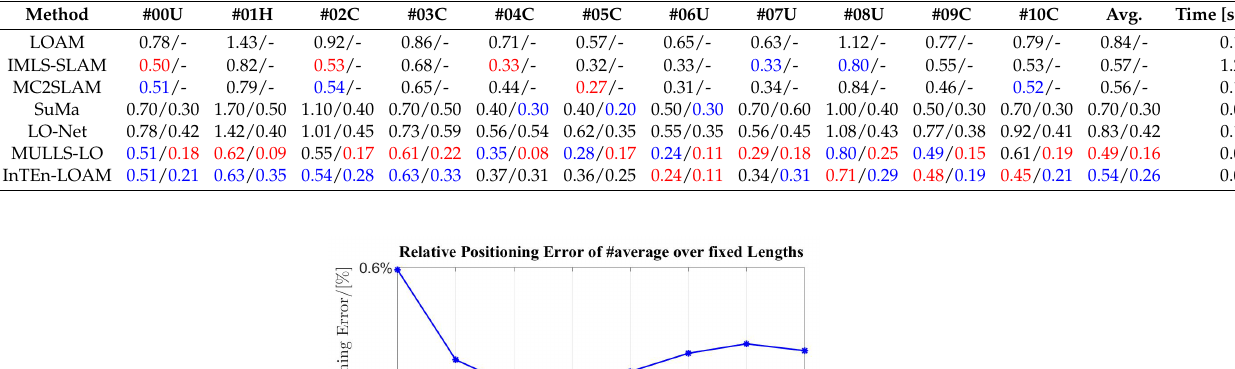
Table 1. Quantitative evaluation and comparison on KITTI dataset. Note: All errors are represented as average RTE [ % ] /RRE [ /100 m]. Red and blue fonts denote the first and second place, respectively. ◦ Denotations: U: Urban road; H: Highway; C: Country road.